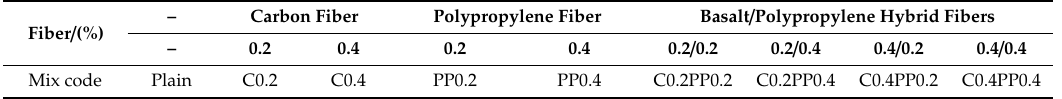
Table 1. Fiber addition of lightweight aggregate concrete (LWAC)